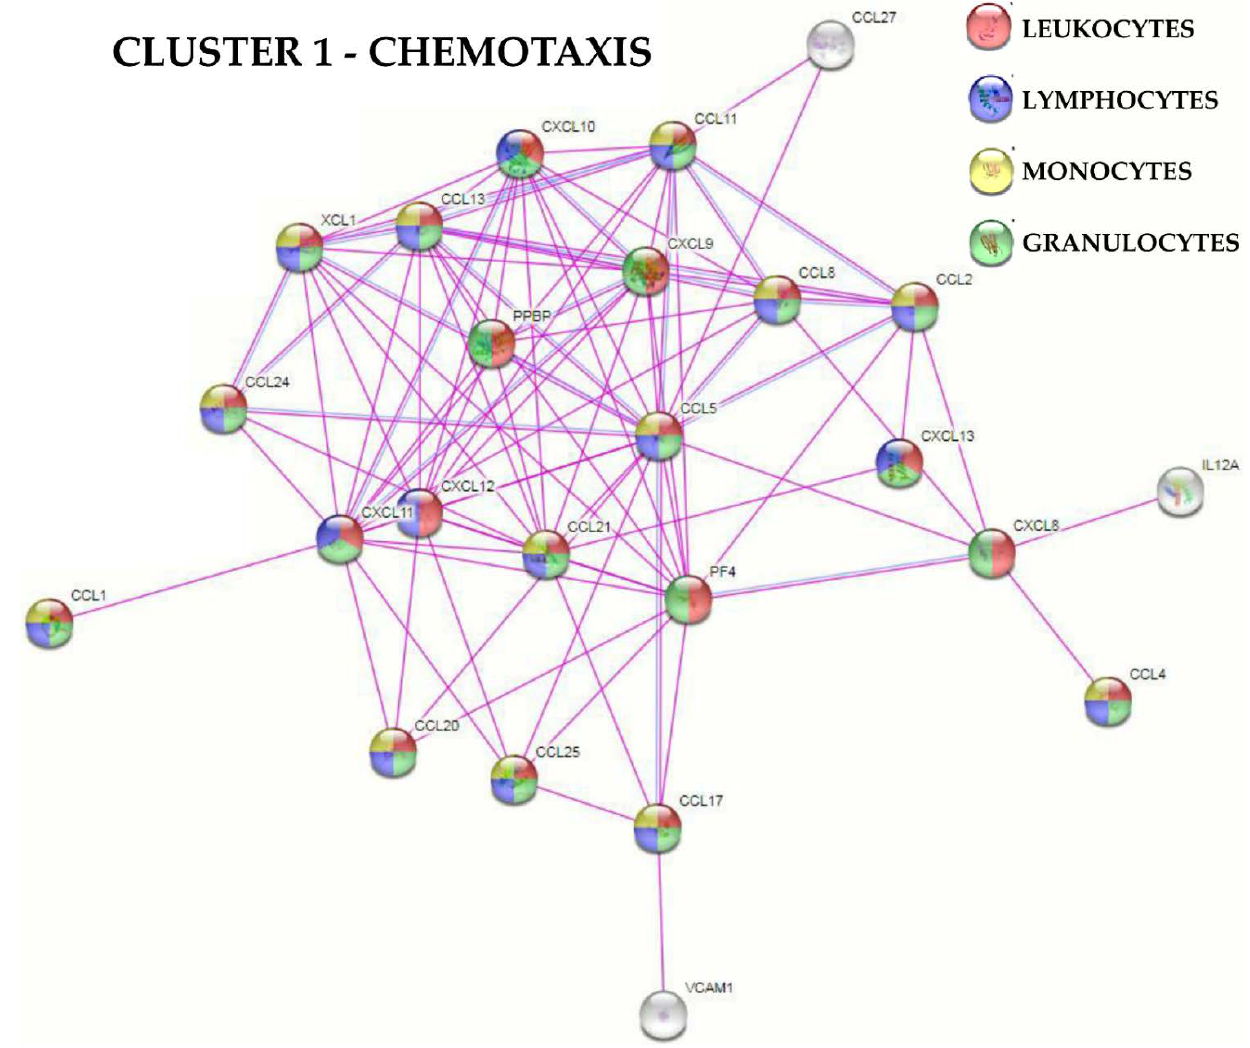
Figure 4. Functional association network for Cluster 1 secreted factors related to the GO term “chemotaxis”. Using the online tool STRING, protein–protein interaction levels for 24 proteins of the BMSCs Cluster 1 related to the GO term “chemotaxis” for leukocytes, lymphocytes, monocytes and granulocytes were mined. The different colors represent the immune cell type the “chemotaxis” term is associated with. The blue connections are for proteins with known interactions based on curated databases; violet connections for proteins with experimentally determined interactions. Colorless nodes for proteins not related to the GO terms: leukocytes chemotaxis, lymphocytes chemotaxis, monocytes chemotaxis and granulocytes chemotaxis in the STRING database v 11.5. Empty nodes, proteins of unknown 3D structure; filled nodes, known or predicted 3D structure.